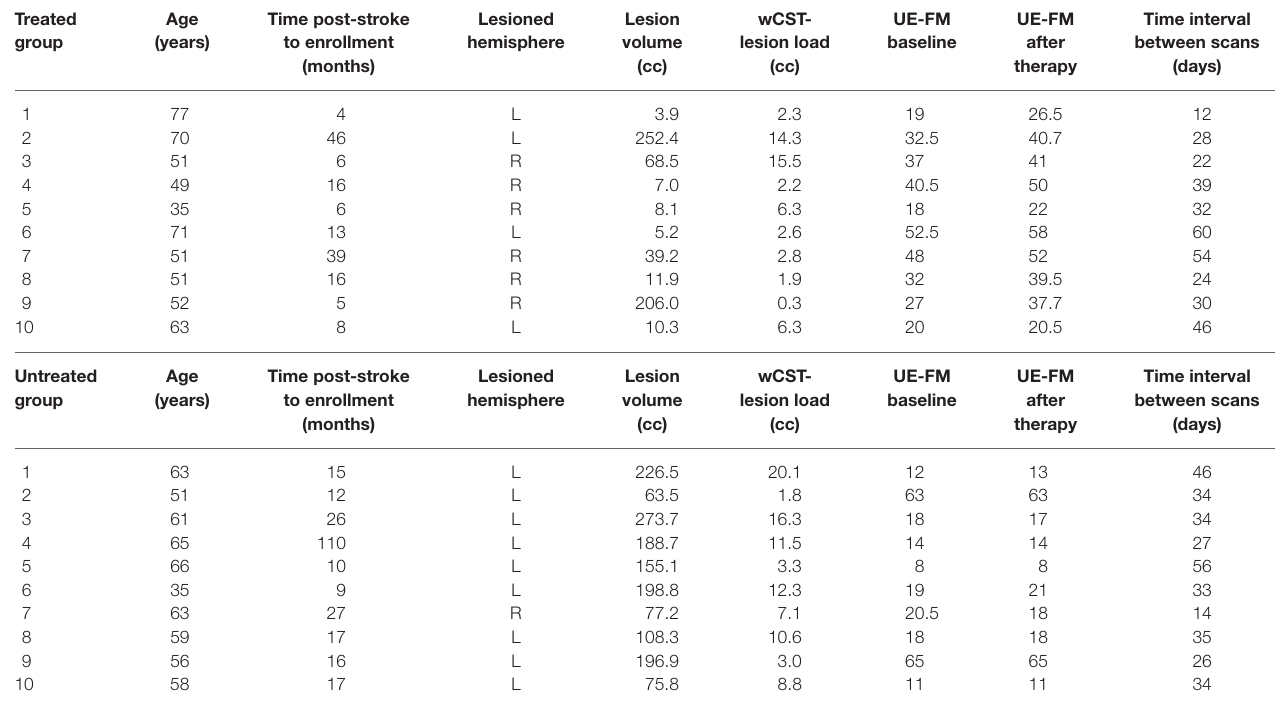
TABLE 1 | Biographical and and lesion information for patients in the treated and untreated groups . Treated